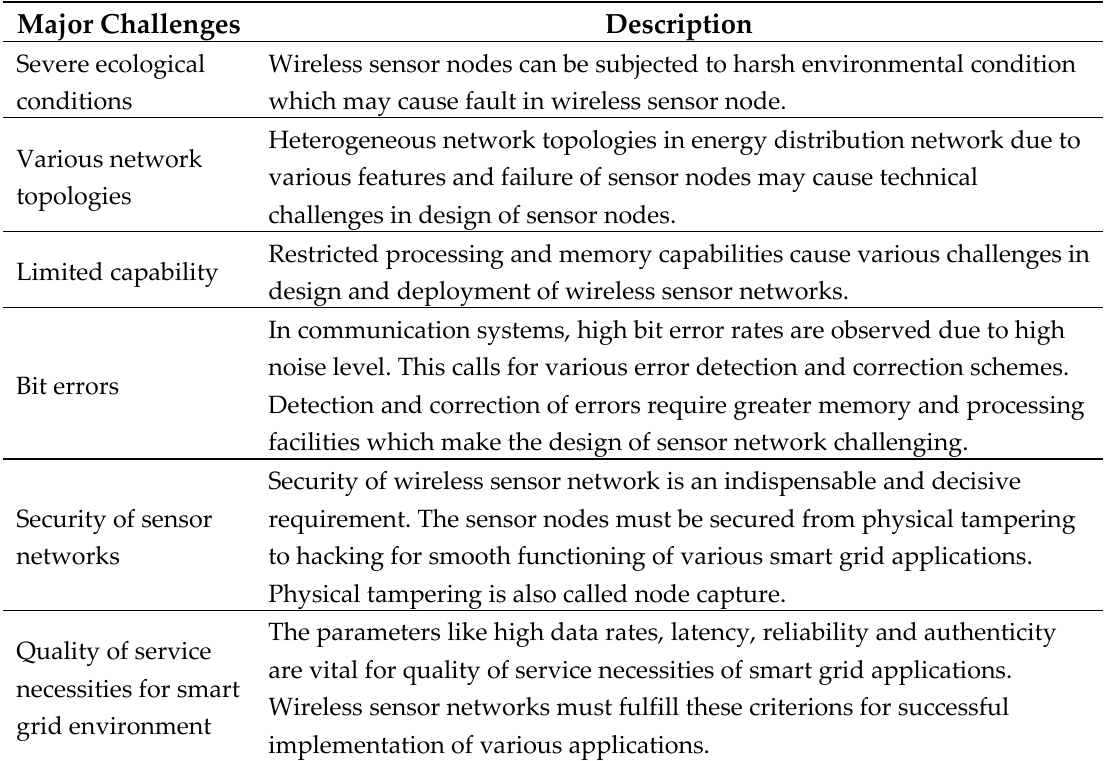
Table 1. Challenges of